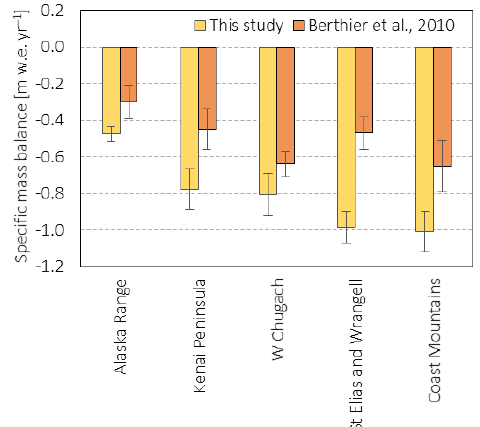
Figure 12. Gulf of Alaska (GoA) specific mass balance trends, ag- gregated on the sub-regions by Berthier et al. (2010). The figure compares our results (July 2010 to July 2019) to the estimates of Berthier et al. (2010), covering the time period 1962 to